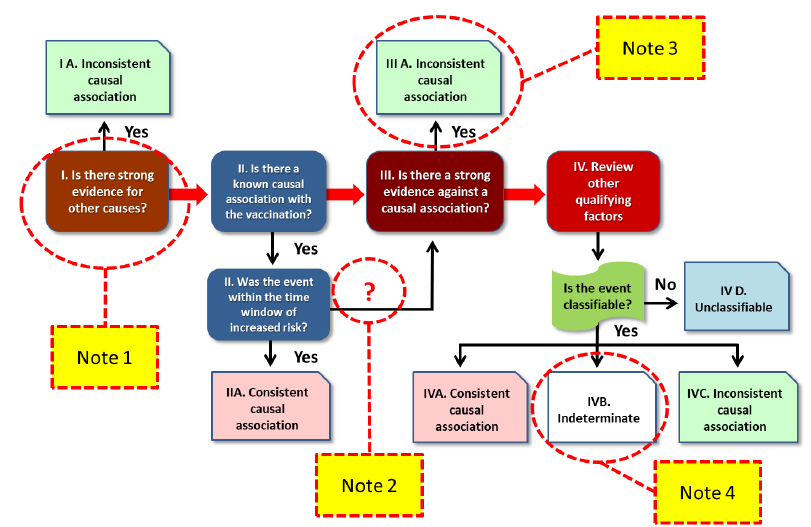
Figure 3. The WHO algorithm for causality assessment of AEFI, with the indicated notes discussed in this opinion article (yellow